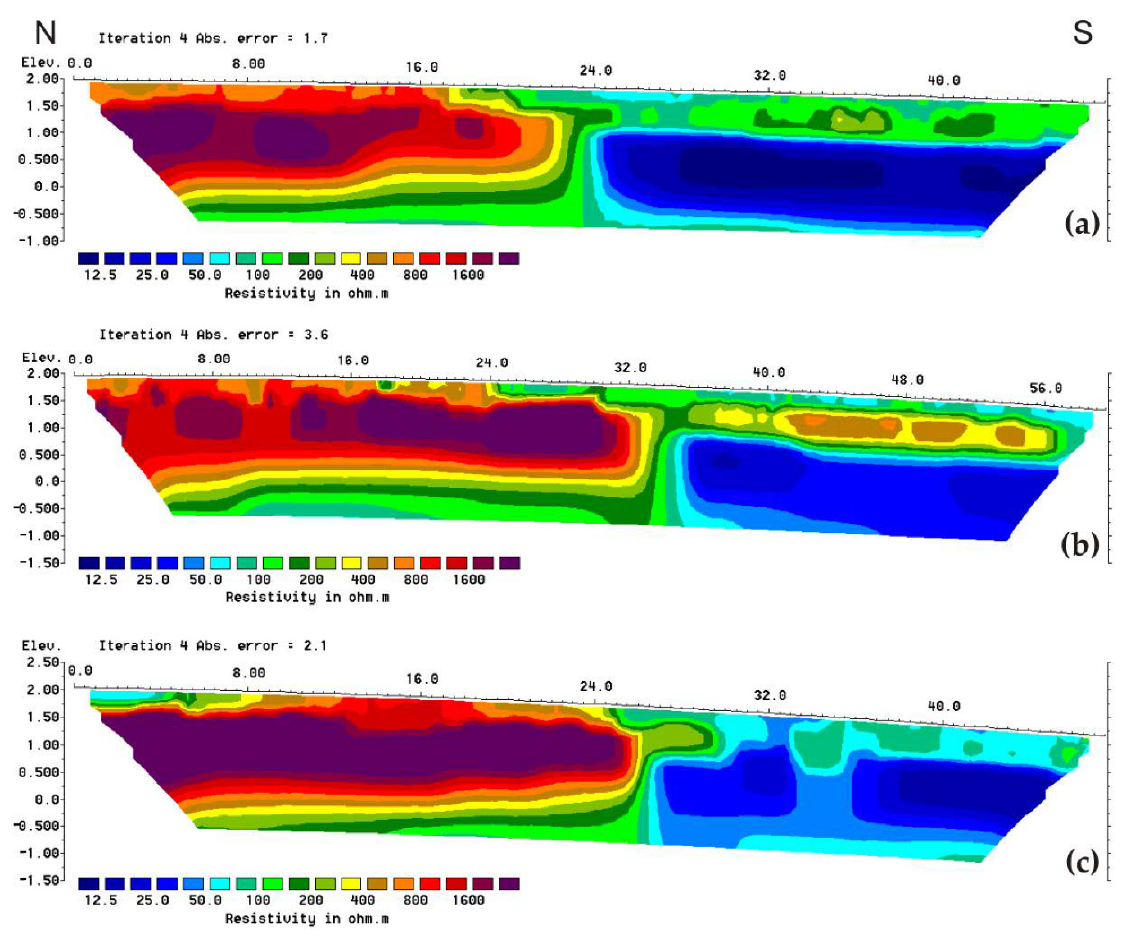
Figure 6. ERI resistivity sections: ( a ) Profile 1, ( b ) Profile 2, and ( c ) Profile 3 (elevation and distance values in m).